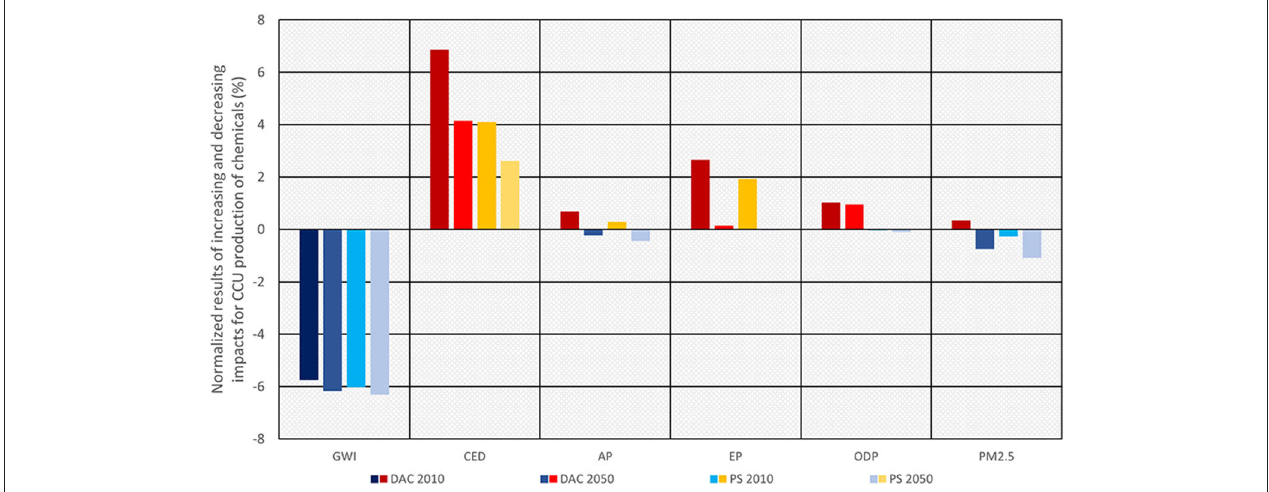
FIGURE 7 | Normalized results for emission reductions (negative, blue) and increases (positive, red) in different impact categories from substitution of fossil products through CCU chemicals in the Federal Republic of Germany in